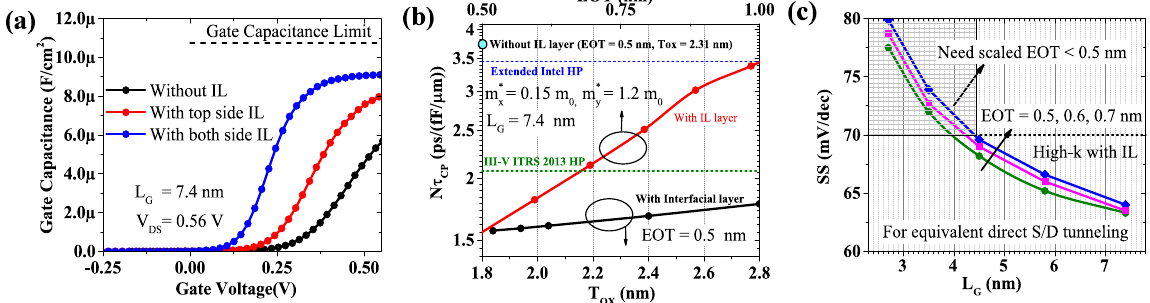
Figure 4. Effect of an interfacial layer (IL) with High-k dielectric, ( a ) On effective gate capacitance with gate voltage, ( b ) On performance (delay) of monolayer BP for N3 technology node i.e. L G = 7.4 nm in two different cases (i) with different EOT, and (ii) with varying physical oxide thickness for same EOT, ( c ) On the scalability of such gate-stack for different EOT considering equivalent direct source/drain tunneling.